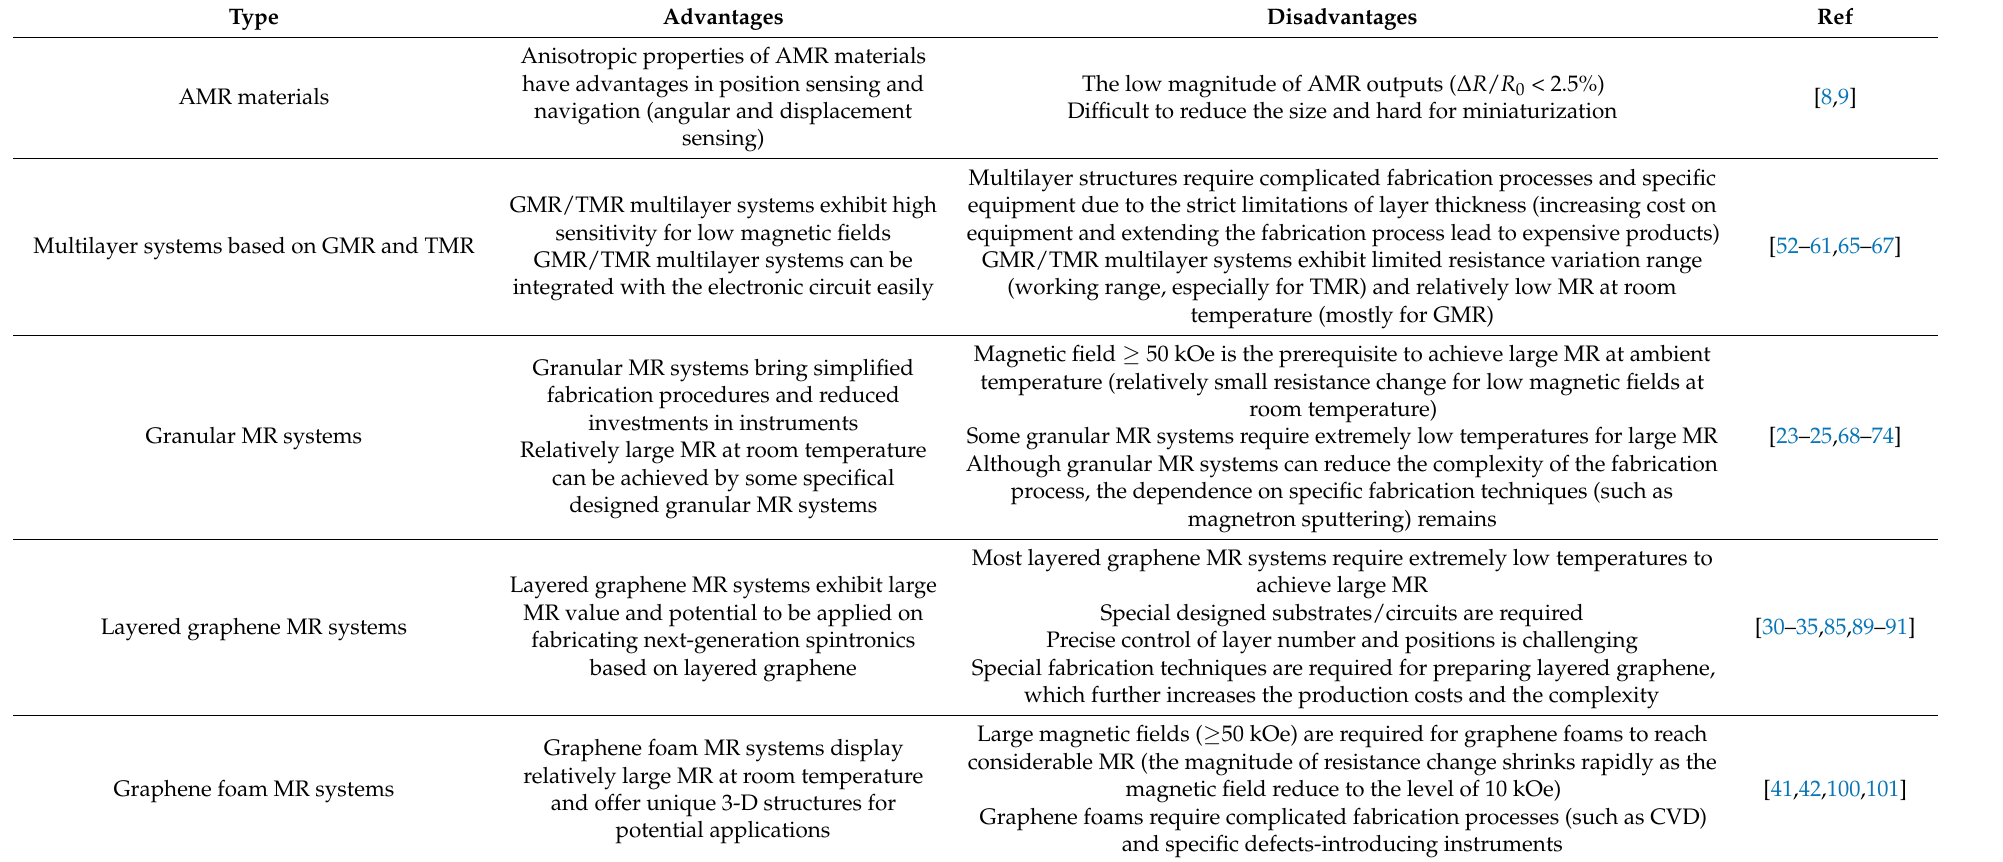
Table 1. Summary of current magnetoresistance (MR)